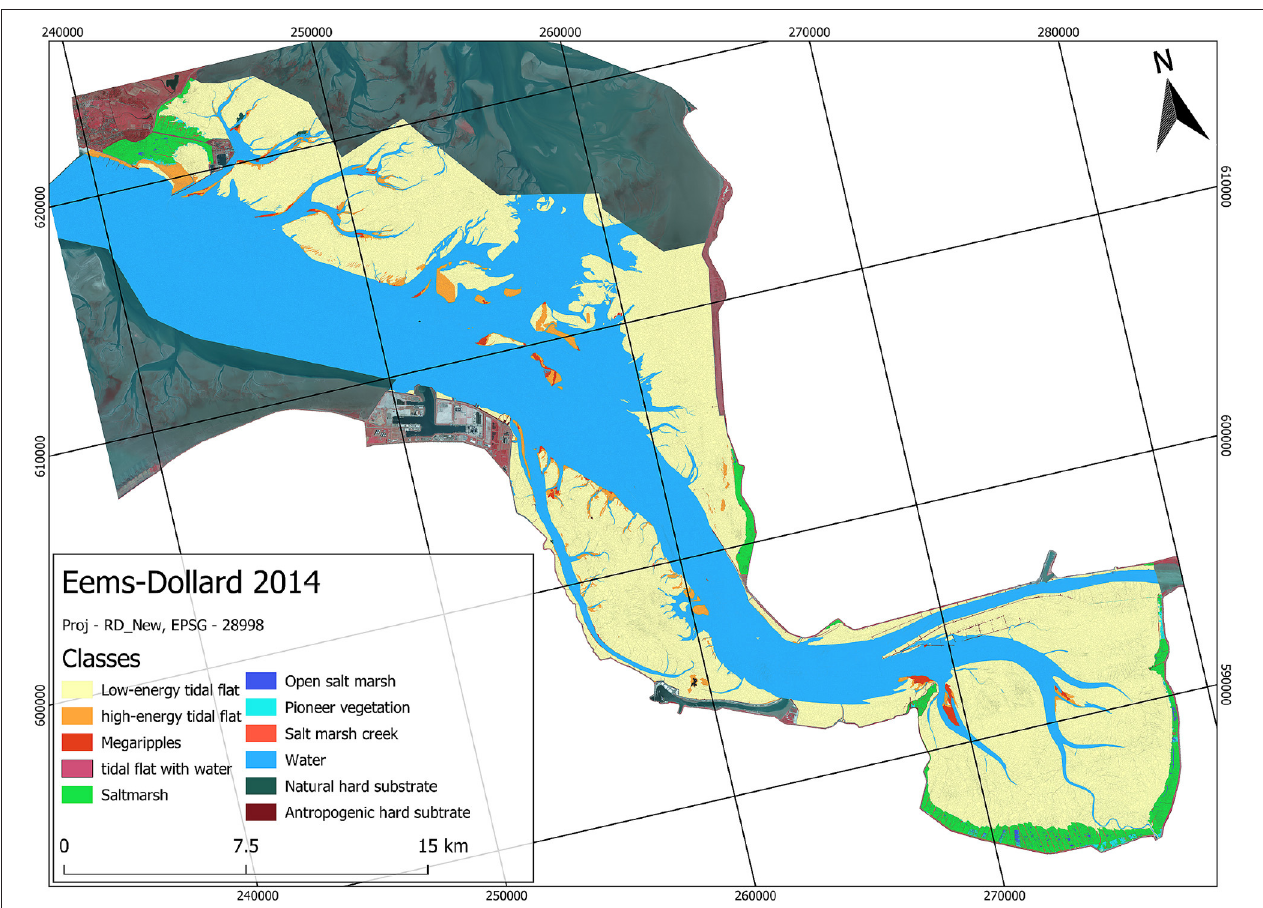
FIGURE 2 | Biogeomorphological map of the Eems-Dollard for 2014 showing boundaries of the objects used in the ruleset. See Table 2 for explanation. Full image resolution maps for all three systems are provided in Supplementary Material